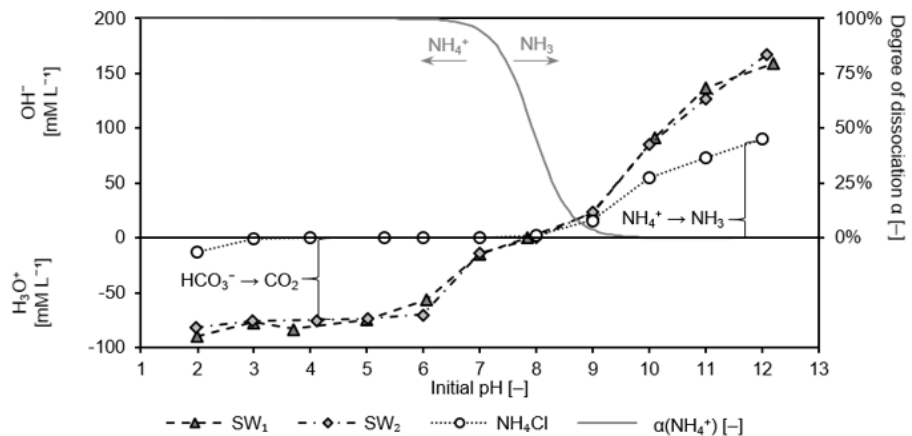
Figure A1. Quantity of OH − (NaOH) and H 3 O + (HCl) to adjust the pH of SW1, SW2, and NH 4 Cl solution as well as the degree of dissociation of ammonium depending on the